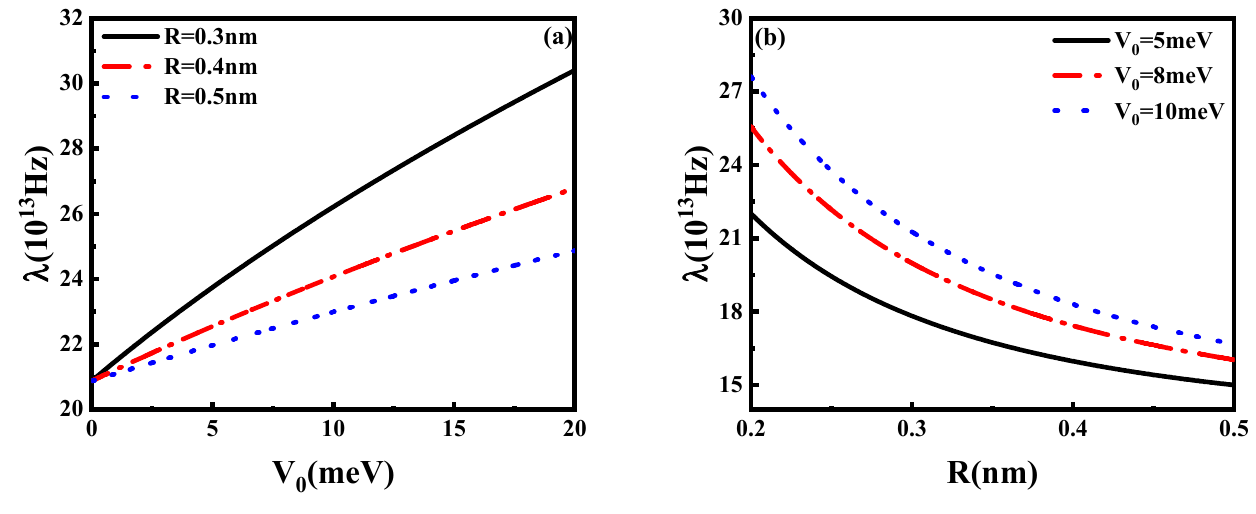
Figure 3. Vibrational frequency λ versus ( a ) AGCP barrier height V